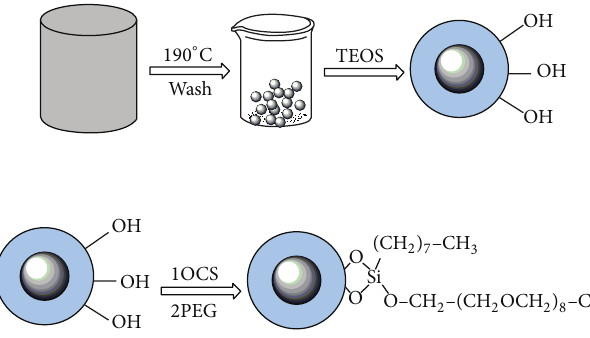
Figure 1: Preparation protocol of the magnetic